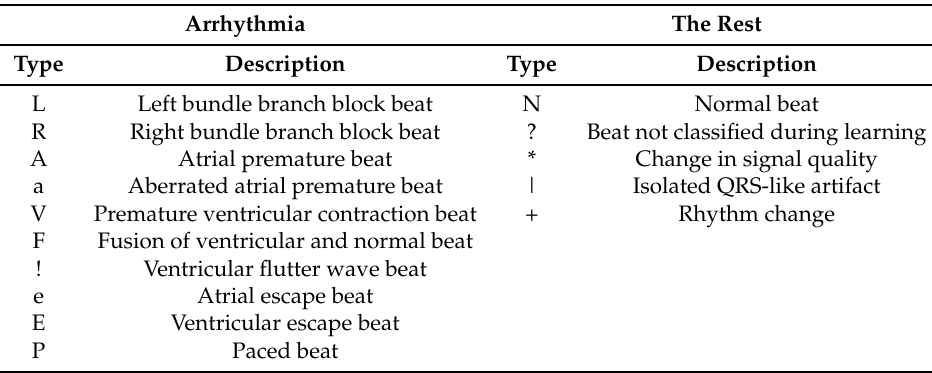
Table 3. Description of heartbeat